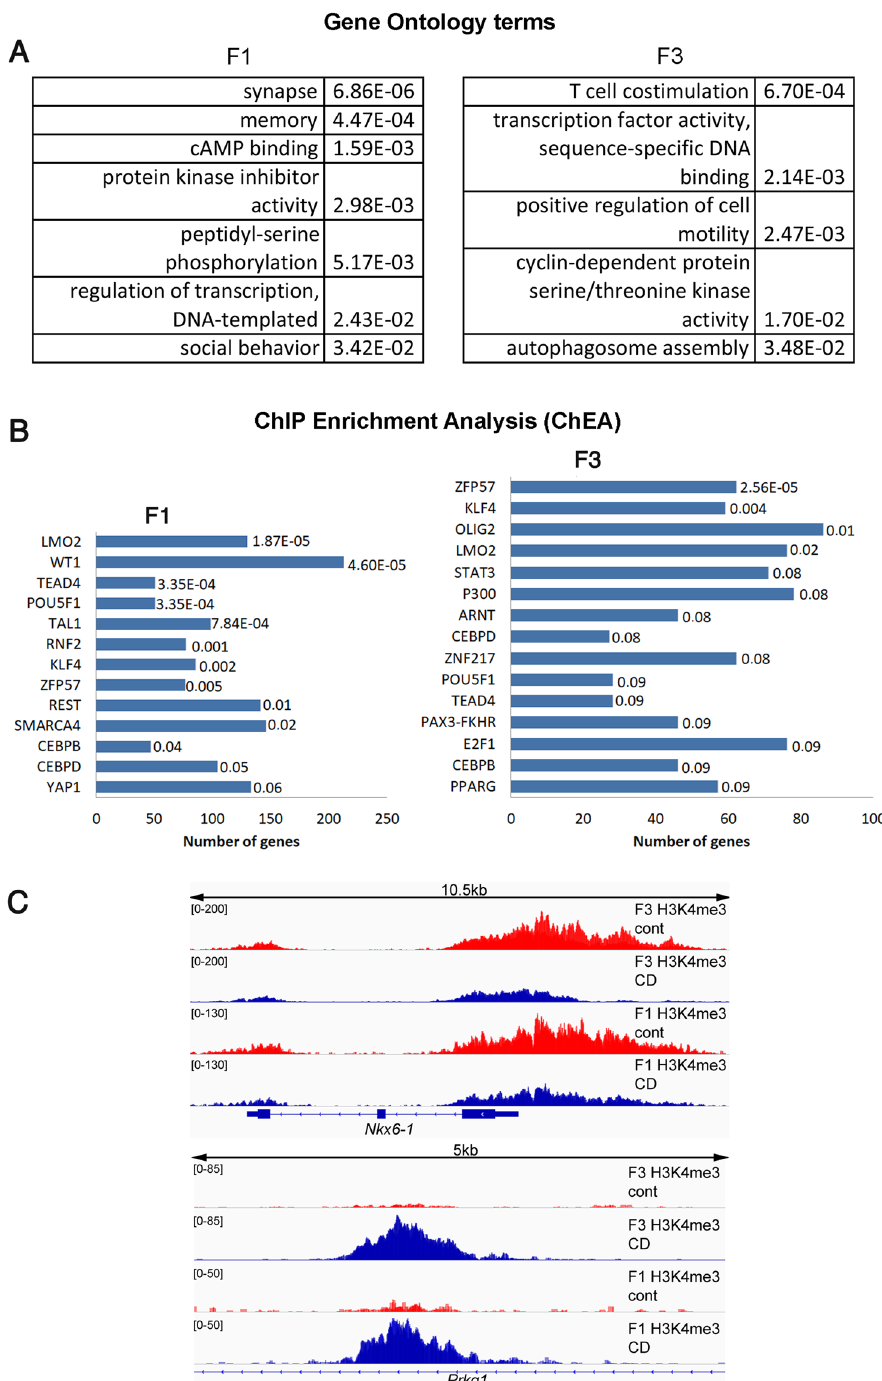
Figure 5. Histone H3K4me3 occupancy is globally affected in F1 and F3 generations following CD treatment. ( A ) The gene ontology (GO) terms are sorted based on p -value, calculated by DAVID, p -values are indicated against GO terms in the table, Fisher’s exact test. ( B ) Enrichment in GO terms located within the differential peaks identified by ChEA. Terms are sorted based on adjusted p -values and are indicated at the end of each bar. ( C ) The H3K4me3 occupancies in Nkx6-1 and Prkg1 have been altered in both F1 and F3 generations